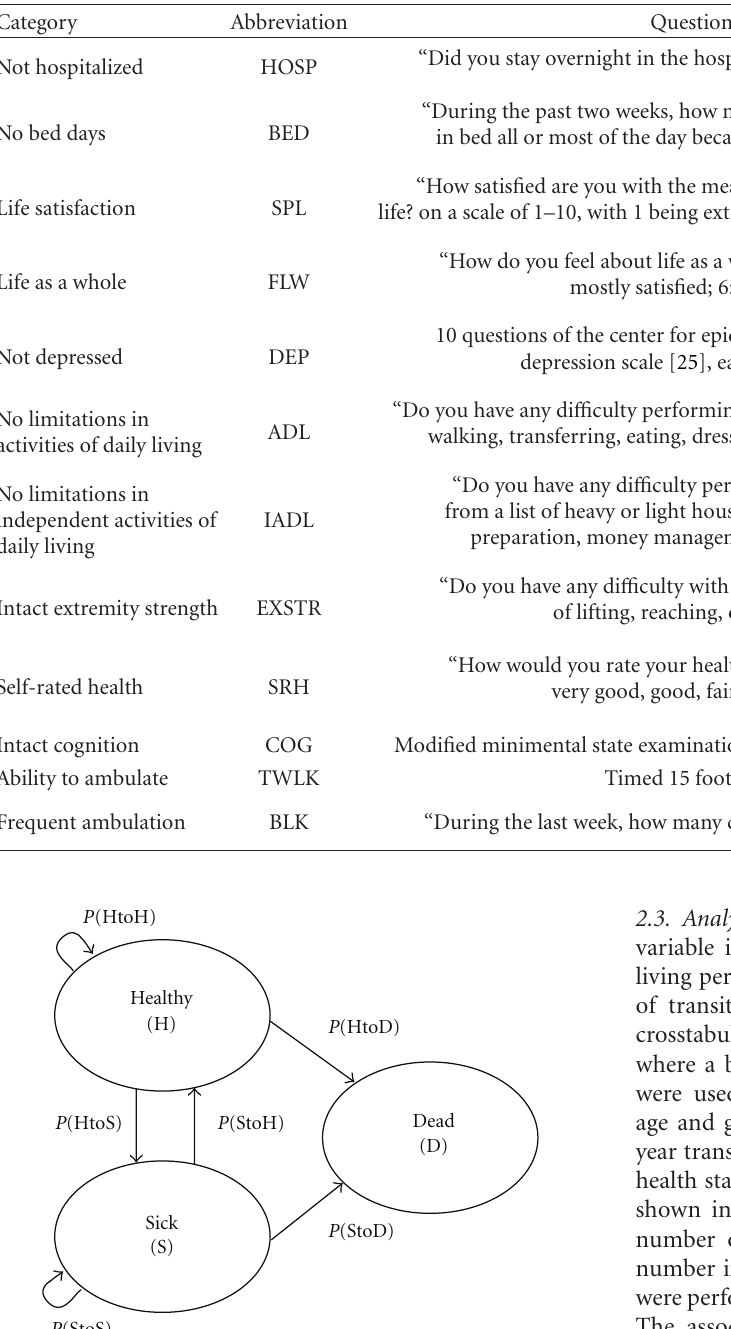
Table 1: 12 Measures of successful aging.